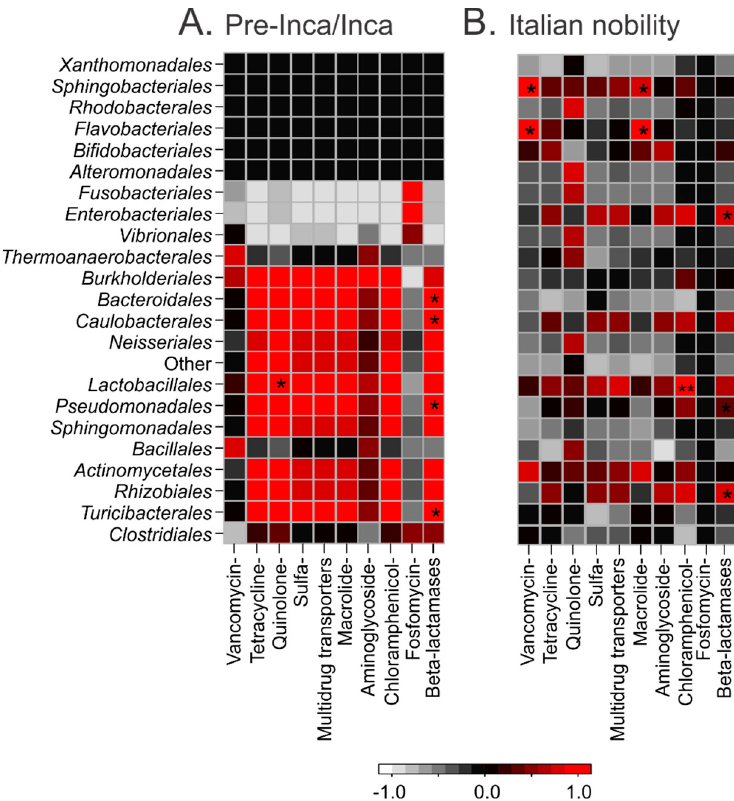
Figure 6. Pearson’s correlations between taxonomy at the order level (left) and the resistome (bottom) of the pre-Inca/Inca (Panel A ) and Italian nobility (Panel B ) mummies. Positive correlations are shown in red, negative correlations are shown in white and no correlations are shown in black. Significance is represented by asterisks: p ≤ 0.05 (*) and p ≤ (0.01) (**).